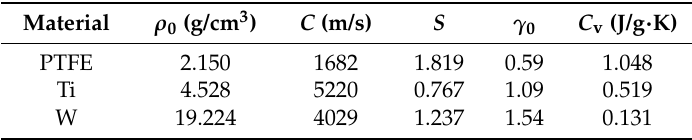
Table 4. Parameters of constituent materials.